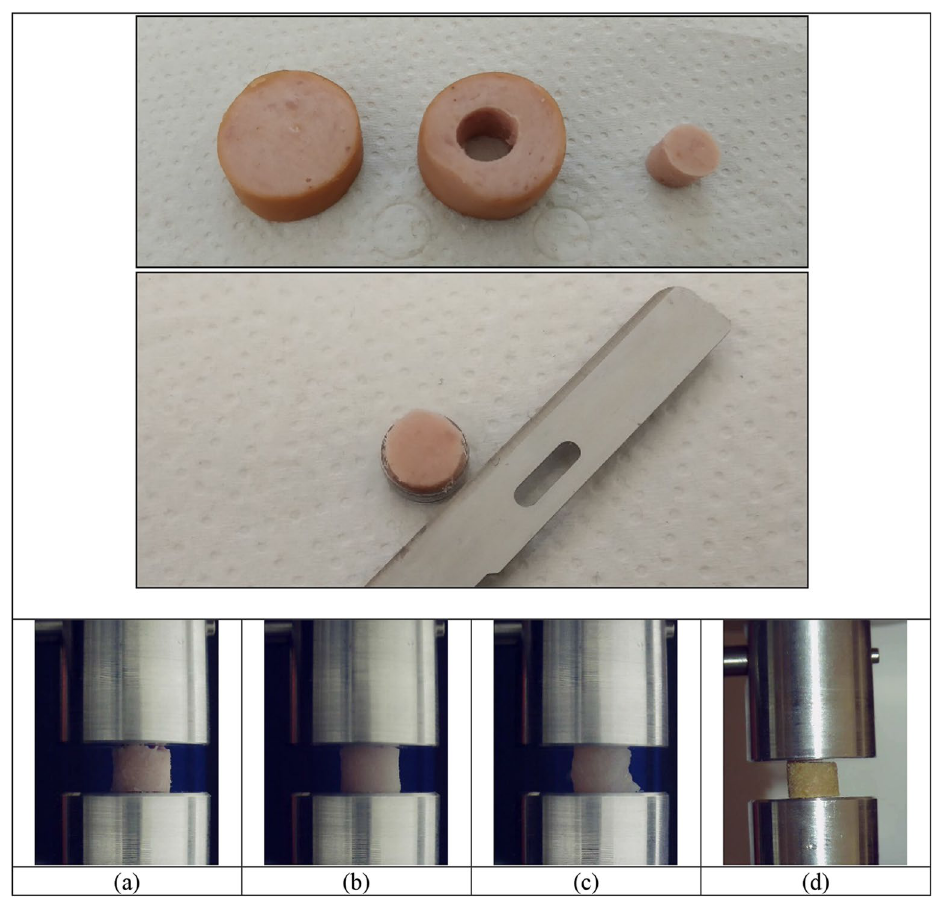
Figure 1. (Top) Process for obtaining the samples. Obtaining a cylinder using an 8 mm punch and placing it on the apparatus to fix its thickness by cutting it to the desired thickness. Process example shown correspond to a sausage. (Bottom) Images correspond to tested samples of Frankfurt style sausage (a) , processed turkey (b) , non-processed chicken (c) and cultured meat Frankfurt style sausage (d)